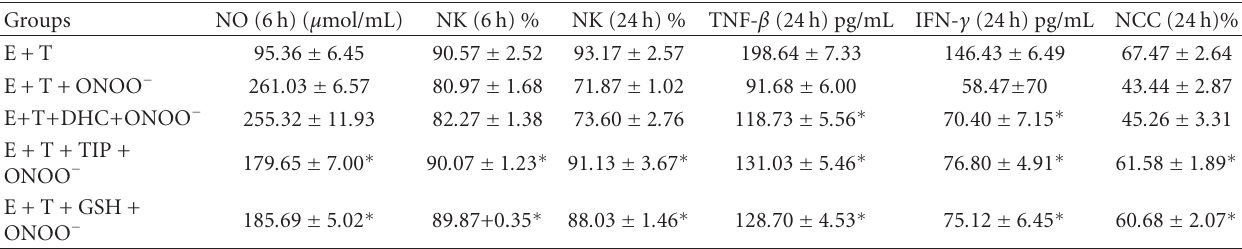
Table 2: The e ff ect of RNM scavengers on NK-cell cytotoxicity of ONOO − .